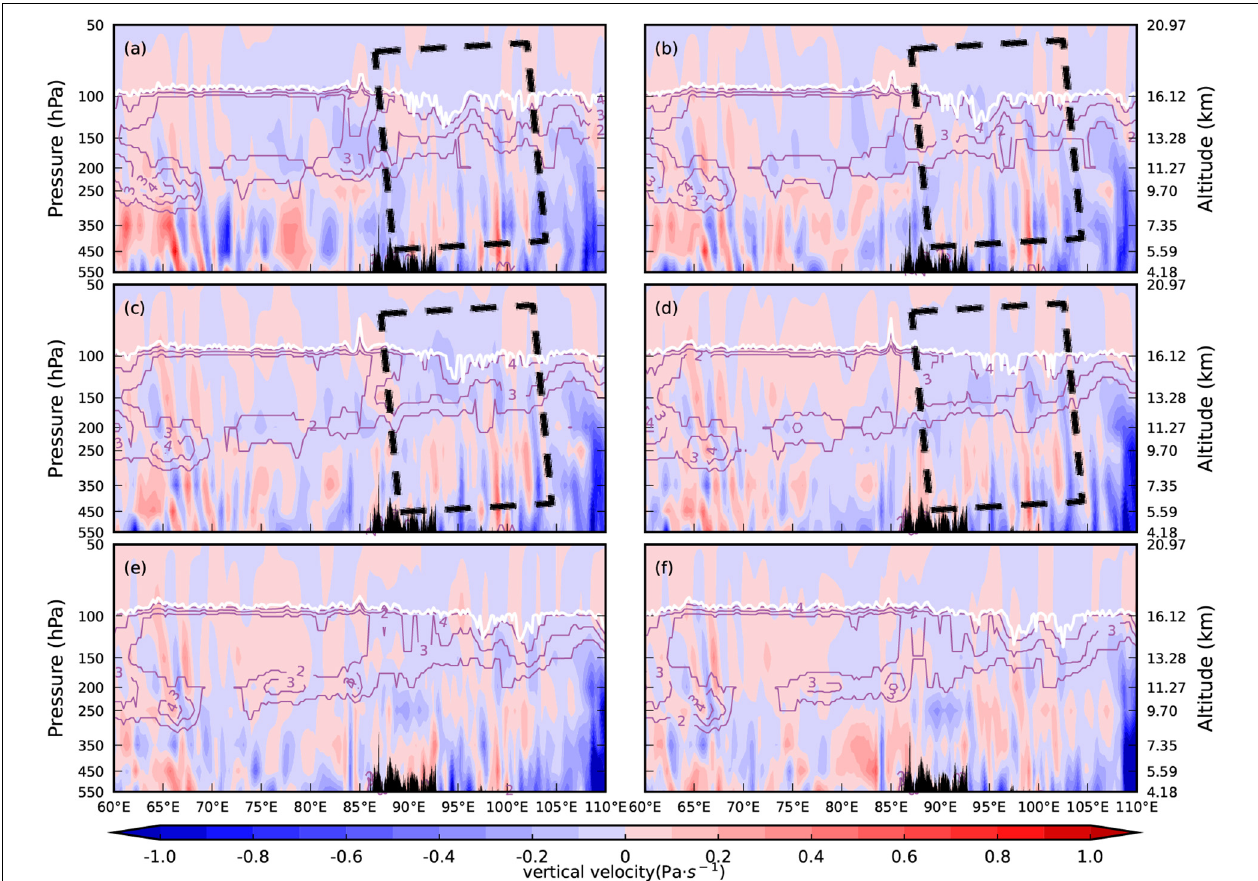
FIGURE 3 | Longitude–height cross section of vertical velocity (unit: Pa s − 1 ) along 28 ◦ N from ERA5 reanalysis data. The solid white lines indicate the thermal tropopause and the solid purple lines indicate potential vorticity (unit: PVU) Times shown are (a) 18:00; (b) 19:00; (c) 20:00; (d) 21:00; (e) 22:00; and (f) 23:00.